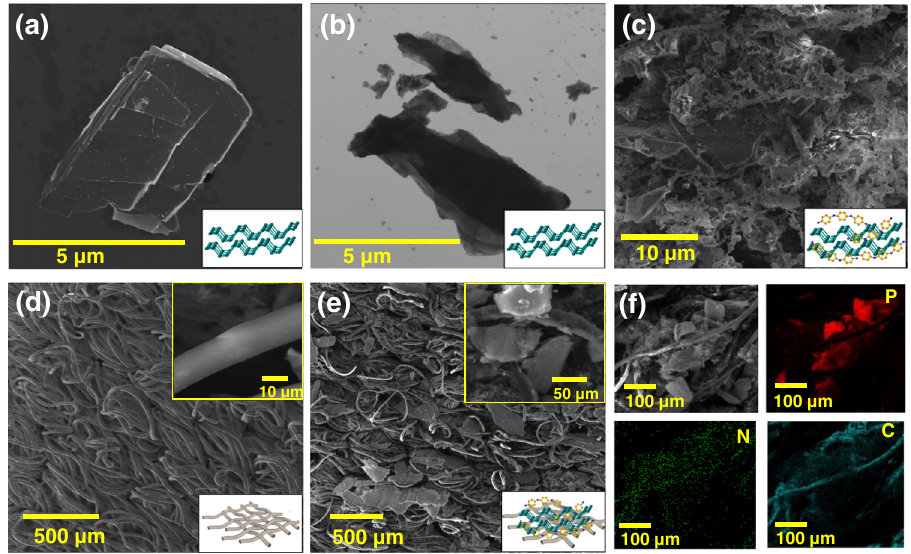
Fig.2|Morphologycharacterizations.a , b SEMandSTEMimagesofpristineBP. c SEMimageofBP@PANIcomposite. d SEMimageofthepristinefabric. e SEMimageof BP@PANI-coated fabric. f EDS mapping of BP@PANI-coated